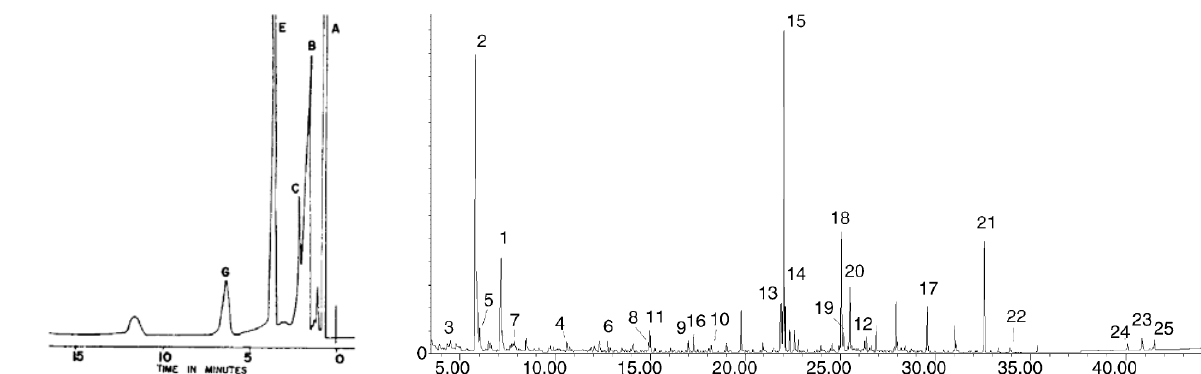
Figure 11. Introduction and development of Pyrolysis GC. Left panel: Early Pyrolysis GC with packed column published in 1959. Sample: polymethylmetacrylate. Packed column, isothermal 100°C; Pyrolysis at 500°C for 30 sec in He atmosphere. Peak annotation: A, air; B, meth- anol; C, ethanol; E, methyl acrylate; G, methyl methacrylate. For details, see text and ref. [87] . From ref. [87] with permission. Right panel: Pyrolysis capillary GC recorded using a state-of-the-art instrument in 2005. T -programmed mode. Detection: TIC of MS. Sample from a painting in “oleoresin” technique. Peak annotation: 23, hop-22(29)-en-3-ol; 24, β-amyrin; 25, α-amyrin; all as TMS esters. For other